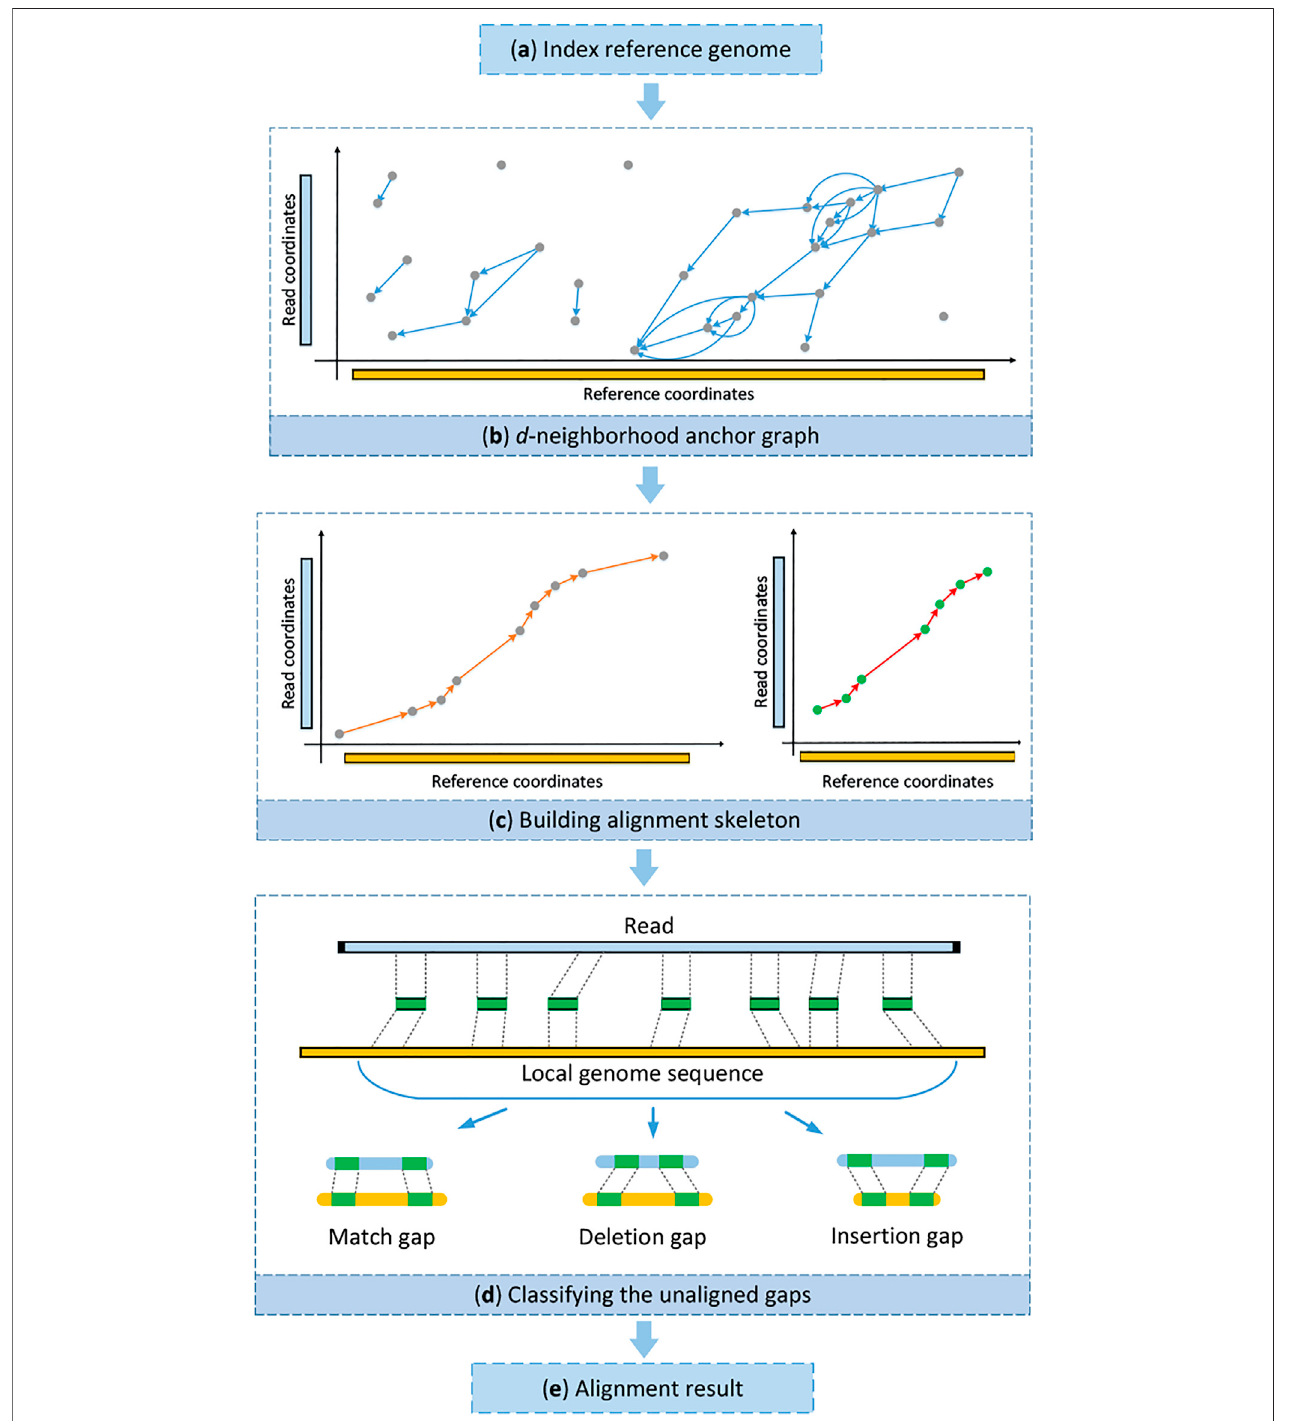
FIGURE 1 | Schematic representation of stages in kngMap. (A) Building a searching index of the reference genome. (B) Constructing a k -mer d -neighborhood graph where matched k -mers (also called anchors) are viewed as vertices and each pair of matched k -mers is connected by a direct edge based on the positions in genome and the query read. (C) Building and re fi ning the high quality of alignment skeletons by designing a chaining approach. (D) Classifying the unaligned gaps betweenpairsofconsecutiveanchormatchesintheselectedchainintoseveralcategoriesofSVeventsandhandlingeachofthemwithaspeci fi calignmentmethod according to its category. (E) Generating the detailed base-to-base alignment by performing dynamic programming between consecutive anchor matches in the selected chain.